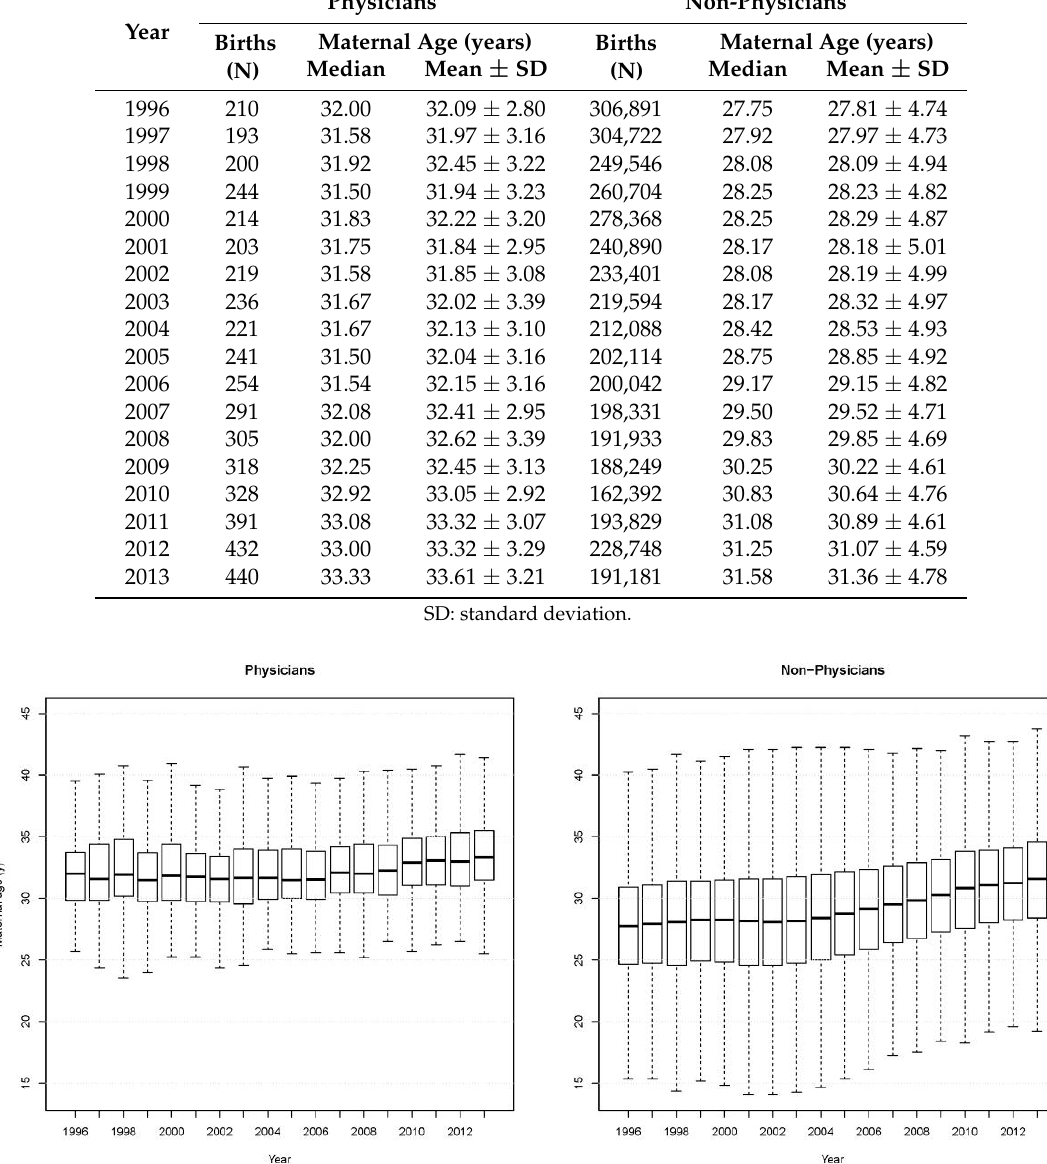
Figure 1. Distribution of maternal age at delivery among female physicians and non-physicians, 1996–2013.